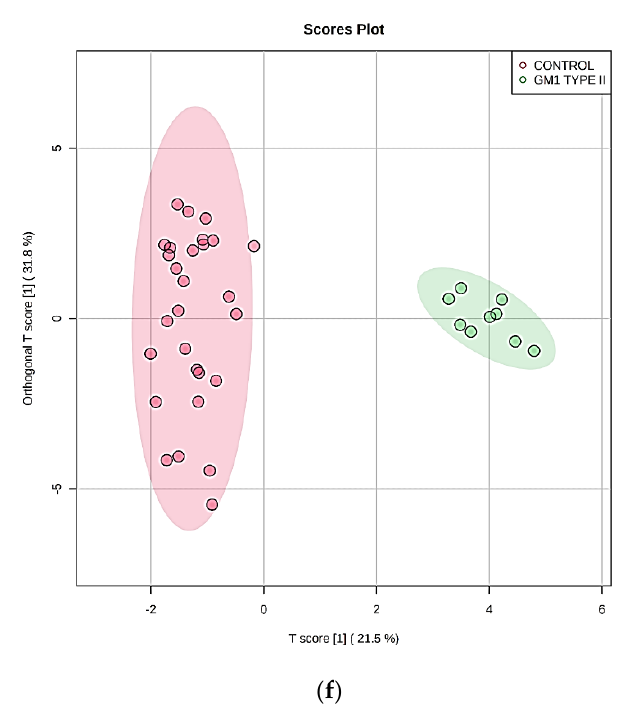
Figure 3. ( a , b ). PCA scores plot of PC3 versus PC1 for the training ( n = 25), and training plus ‘hold-out’ validation ( n = 37 in total) Model 1 datasets, respectively (in ( b ), PC1 and PC3 accounted for 57.2 and 7.1% of total dataset variation respectively). These plots clearly show distinctive clusterings for the HC (red) and GM1T2 patient (green) study classification participants, and ( b ) confirms correct classifications for all hold-out samples evaluated. ( c , d ). Three-dimensional (3D) PLS-DA scores plots of component 3 vs. component 2 vs. component 1 for the training, and training plus hold-out validation, Model 1 datasets, respectively. ( e , f ). OPLS-DA plot of orthogonal T score [1] versus T score [1] for the Model 1 training, and complete 1 H NMR plasma profile dataset, respectively (the latter including the n = 12 validation set held out from the analysis shown in the former), again revealing clear distinctions between the HC and GM1T2 participant clusters. 95% Confidence ellipsoids are also shown for both participant classifications and their validation sub-sets.